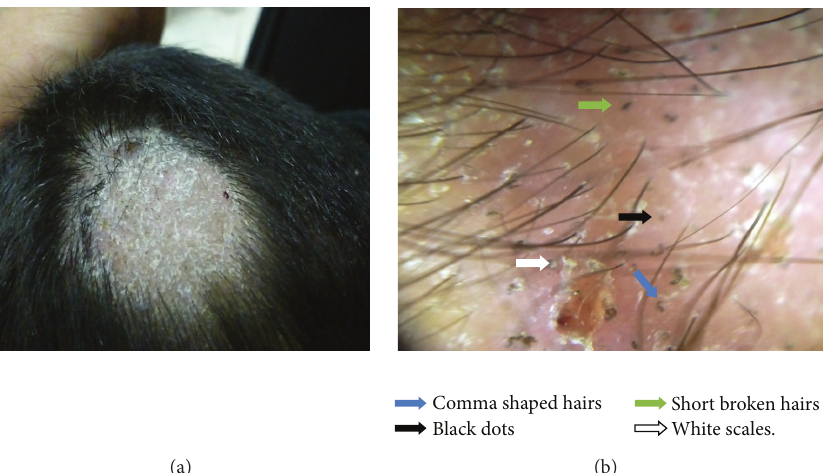
Figure1:Tineacapitis(a)macroscopicview,(b)trichoscopicviewat20xmagnification,dermoscopyshowscommashapedhairs(bluearrow), black dot (black arrow), short broken hairs (green arrow), and white scales (white arrow).